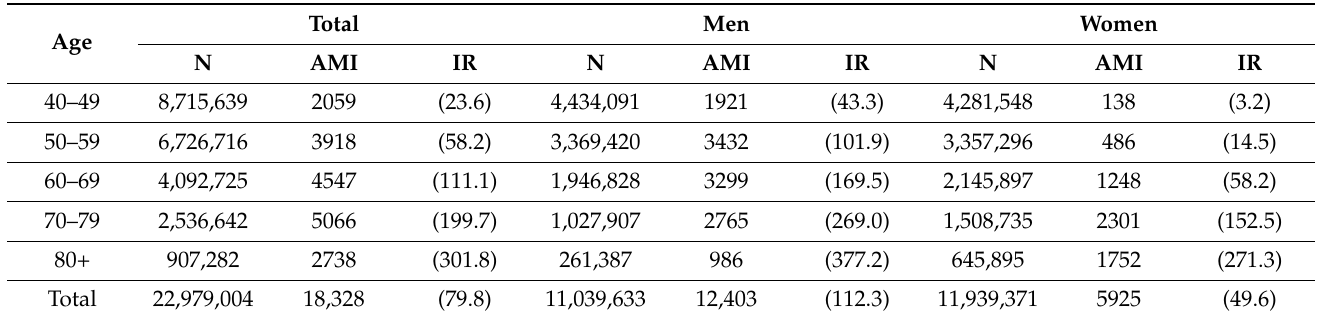
Table 1. Incidence rate of newly diagnosed AMI according to age and sex in